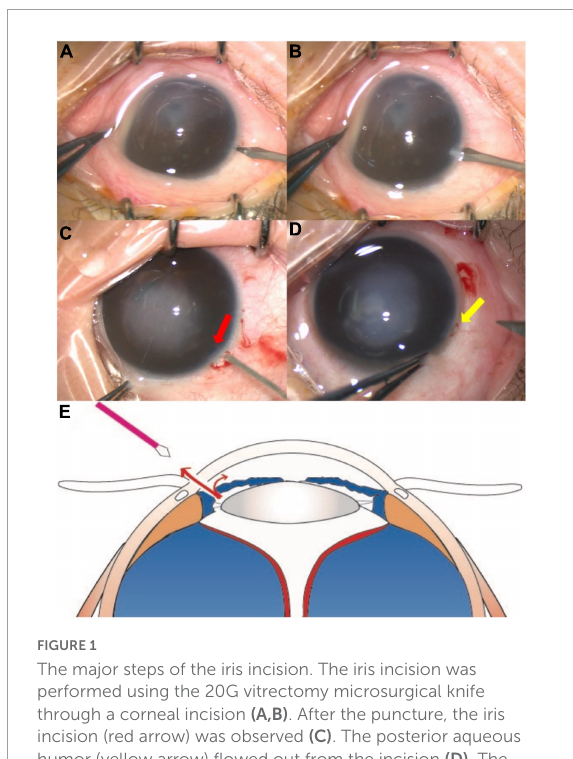
TABLE 1 Demographic information of patients.